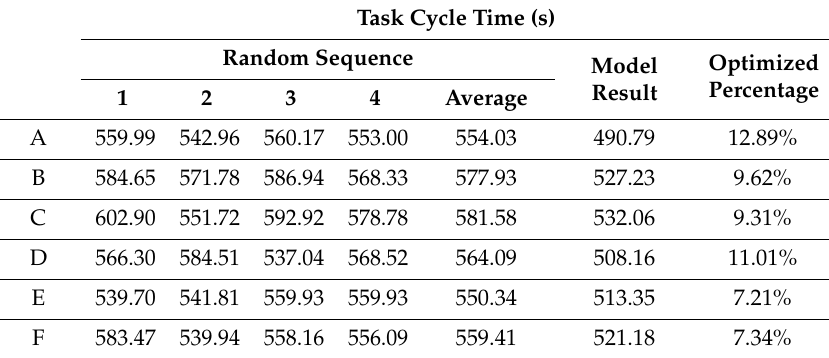
Table 6. Model calculation